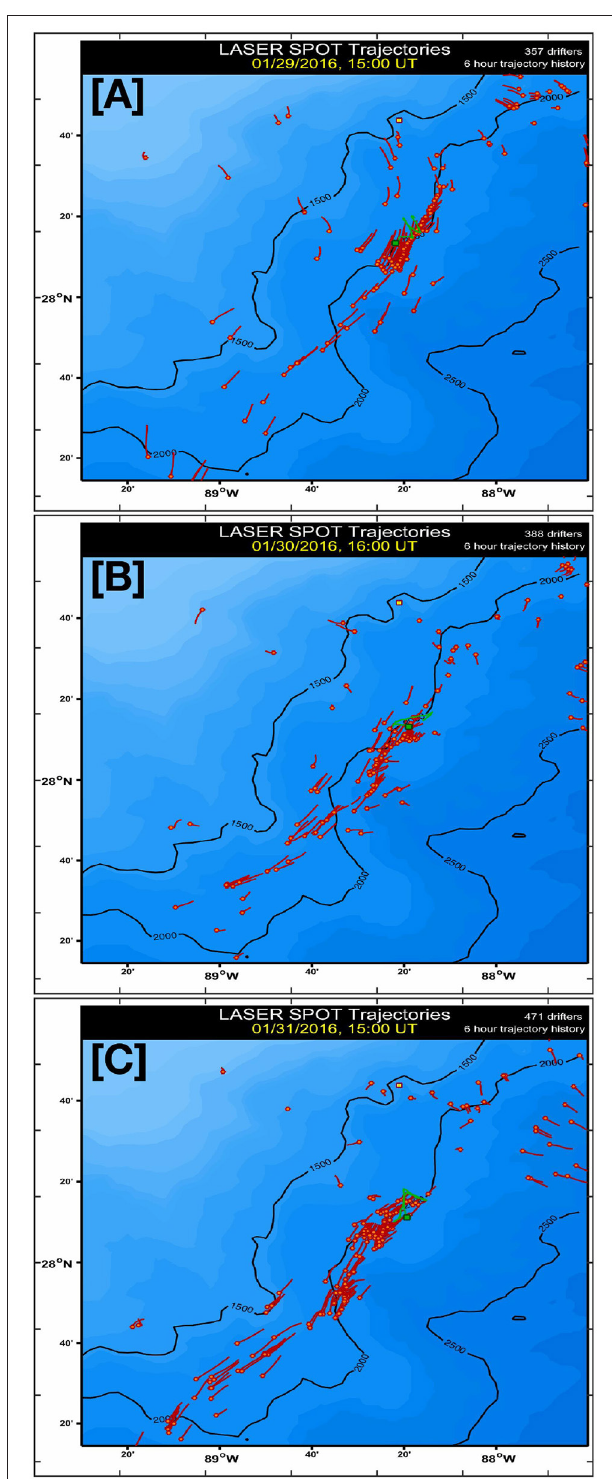
FIGURE 8 | Trajectories of LASER surface drifters deployed in the region on (A) 29 January, (B) 30 January, and (C) 31 January reveal the scale of the front sampled by STARSS. The tails correspond to the previous 6 hr positions and the green line corresponds to the R/V Walton Smith’s position.